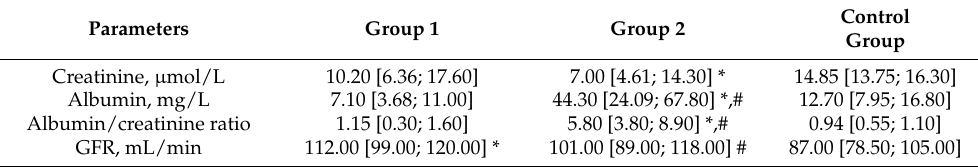
Table 3. Biochemical urine parameters of of men with T1DM (Me, [Q1; Q3]). Parameters